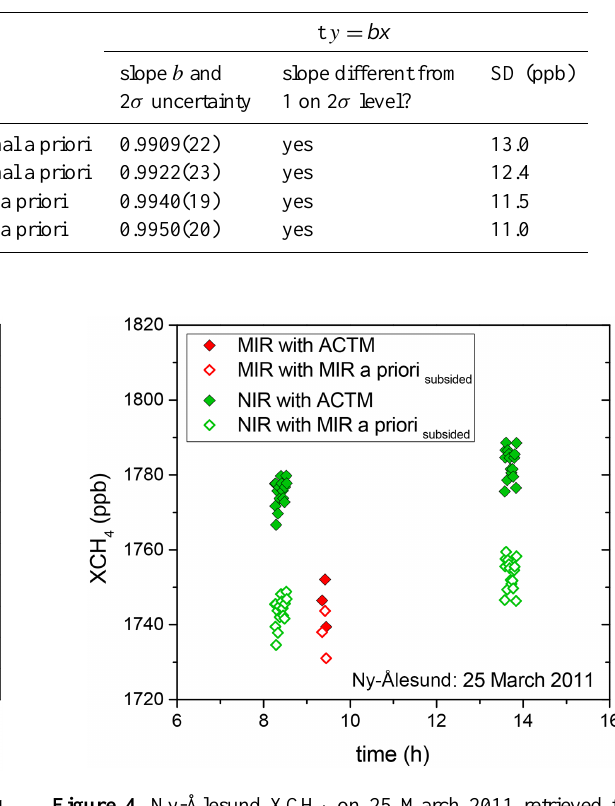
Figure 3. (a) A priori profiles used for analysis of Ny-Ålesund spectra recorded on 25 March 2011. MIR a priori is the stan- dard a priori profile from WACCM for Ny-Ålesund used in SFIT. NIR a priori is the current a priori profile of GFIT (re- lease ggg_2012_July_Update) for Ny-Ålesund. ACTM is the ac- tual ACTM profile for 25 March 2011 used as a common prior for standard intercomparison of the NIR and MIR retrievals. MIR a priori subsided is a strongly subsided profile typical for intravortex conditions as explained in Appendix B used for recorrection of the NIR and MIR retrievals in a more realistic intercomparison. (b) Av- eraging kernels for MIR and NIR retrievals using Ny-Ålesund spec- tra recorded on 25 March 2011.